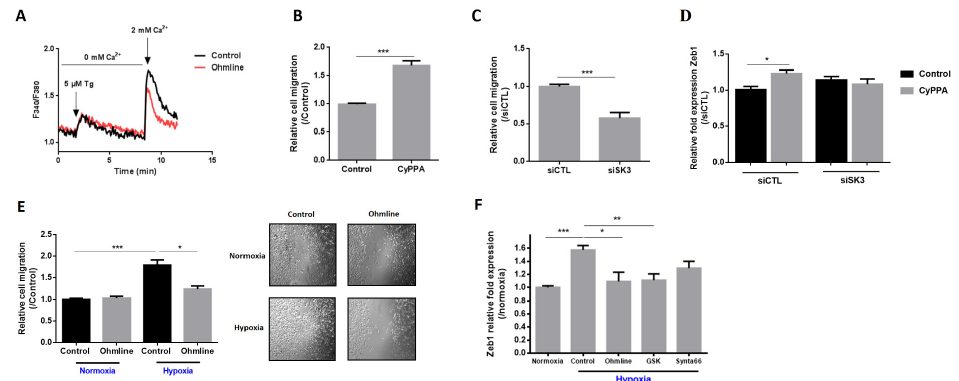
Figure 2. SK3 channel induces Zeb1 expression and cell migration under hypoxia conditions. ( A ) SOCE is inhibited by Ohmline (an SK3 inhibitor). Fluorescence measurements and